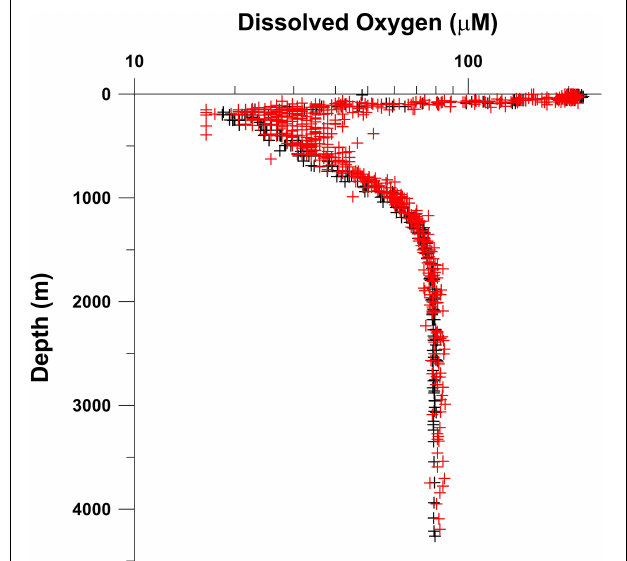
FIGURE 8 | Comparison of oxygen data from the Andaman Sea collected during the International Indian Ocean Expedition (1961–1964) (red symbols) with those taken on a cruise of R.V. Knorr (black symbols) in October